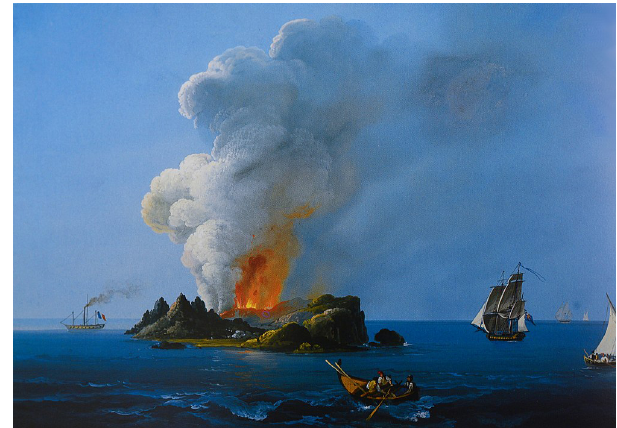
Figure 1. The Ferdinandea island (Graham Island) in a painting by Camillo de Vito in 1831. Source: